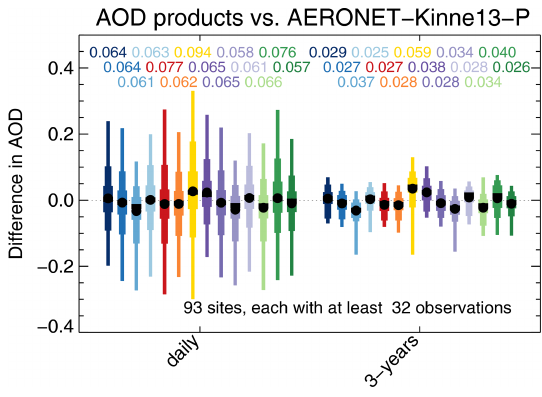
Figure 7. Evaluation of satellite products with AERONET, either for daily data or 3-year averages. The box-and-whisker plot shows 2%, 9%, 25%, 75%, 91% and 98% quantiles, as well as me- dian (block) and mean (circle). Numbers above the whiskers in- dicate mean sign-less product errors. Colours indicate the satellite product; see also Fig. 1. Products were individually collocated with AERONET (Kinne et al., 2013, selection, pruned) within 1h. All products use the same sites, each of which produced at least 32 col- locations with each product.